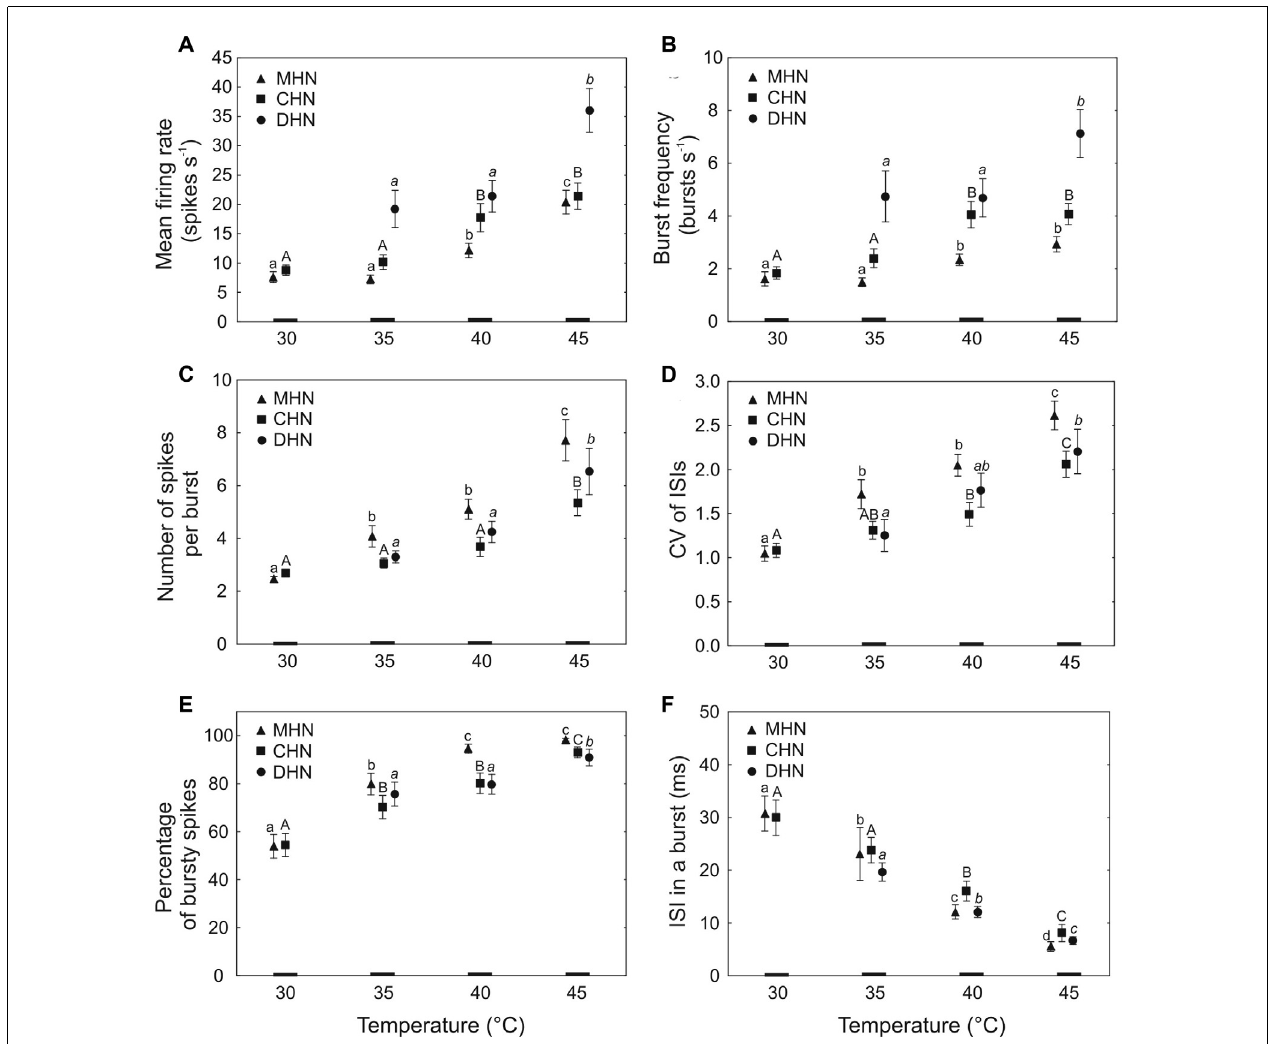
FIGURE 4 | Dependence of bursty spike train parameters (mean ± standard error) of the antennal DSS neurons on temperature (A–F) . Different lowercase normal, uppercase normal, and lowercase italic letters show significant differences between the means at P < 0.05 (Kruskal–Wallis test) for the MHN, CHN, and DHN, respectively. The number of tested insects ( N ) for each data point = 17–30. CV, coefficient of variation; ISI, inter-spike